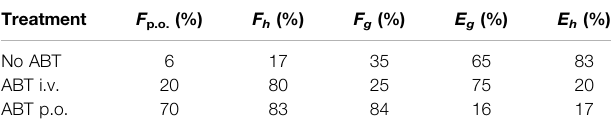
TABLE 6 | Oral bioavailability and estimated hepatic and gastrointestinal extraction values for YL-IPA08 using ABT blocking metabolism (n (cid:2) 6). Treatment